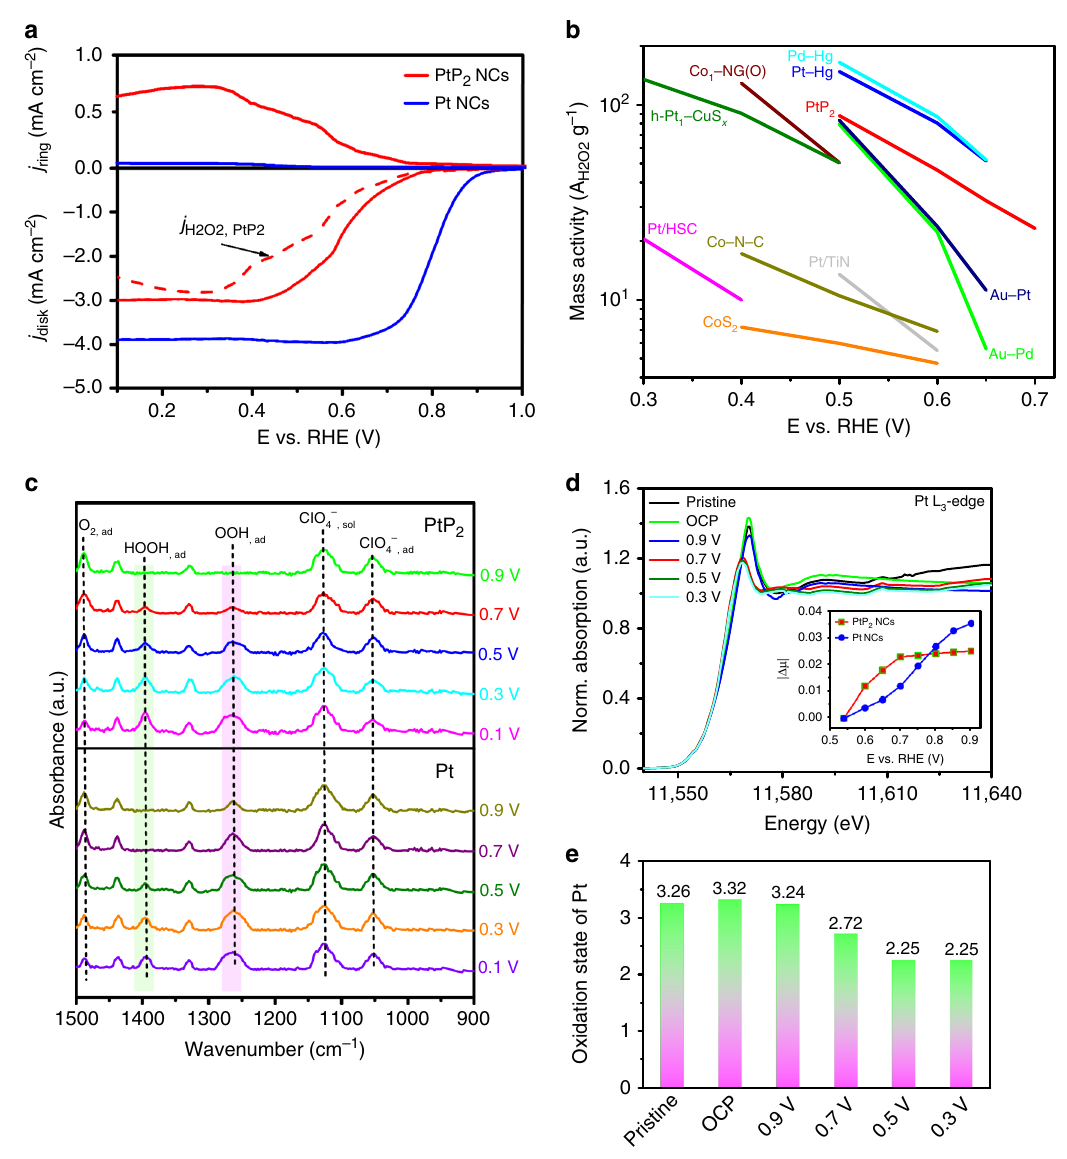
Fig. 2 Electrochemical and in situ characterization of PtP 2 NCs. a RRDE voltammograms at 1600 rpm in O 2 -saturated electrolyte with the disk current density, ring current density, and current density corresponding to hydrogen peroxide obtained from the ring current. b Mass activity of different electrocatalysts for H 2 O 2 production in acidic electrolyte. c In situ ATR-IR spectra and d in situ Pt L 3 -edge XANES spectra collected on the PtP 2 electrodes at constant potential in O 2 -saturated 0.1 M HClO 4 . Inset in d shows the impact of potential on the Pt L 3 -edge XANES spectra: Δ μ = μ ( V ) − μ (0.54 V). e Pt oxidation state in PtP 2 as a functional of applied constant